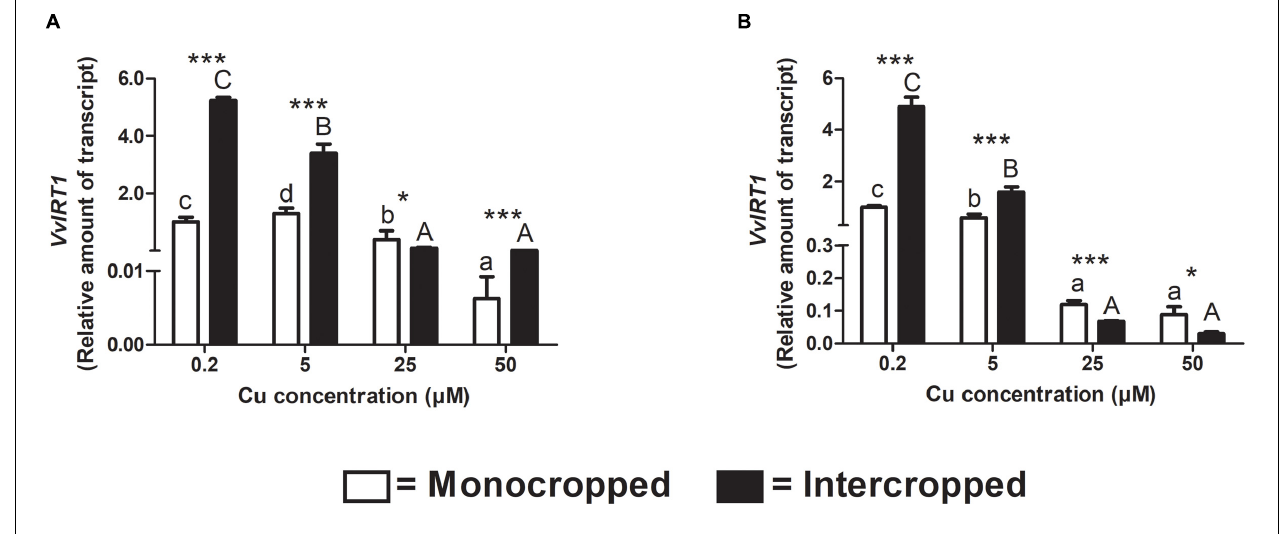
FIGURE 9 | Quantitative real time RT-PCR analyses of VvIRT1 genes in rootstock plants. Root apex gene expression of VvIRT1 determined in mono- and intercropped Fercal (A) and 196.17 (B) rootstocks. Transcripts levels are reported as relative amount of transcripts referred to the gene expression of monocropped rootstock grown at 0.2 µ M Cu. The data are reported as means ± SE of three biological replicates. Different letters indicate significantly different values as determined using one-way ANOVA with Tukey post hoc tests ( p < 0.05). Lower case letters indicate the statistical significance for monocropped plants in the different Cu concentrations, whilst upper case letters indicate the statistical significance for intercropped plants grown in the different Cu concentrations. Stars indicate the significance (Student’s t -test) between the gene expression of mono- and intercropped rootstocks ( ∗ p < 0.05; ∗∗ p < 0.01; ∗∗∗ p <